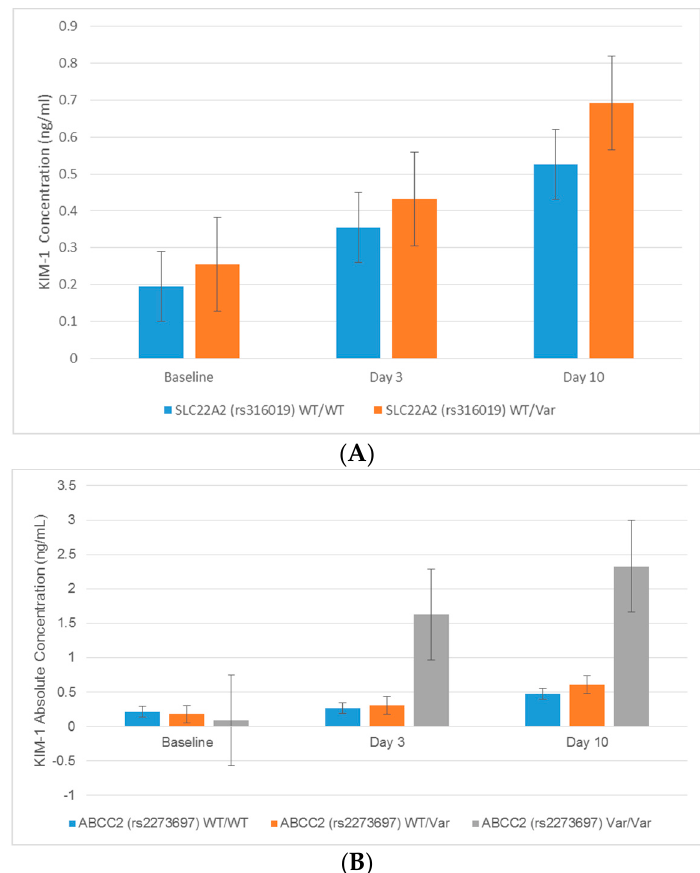
Figure 2. ( A ) Comparison of absolute KIM-1 concentrations by SLC22A2 (rs316019) genotype in ambulatory cancer patients prescribed cisplatin. Statistically significant increases of KIM-1 at baseline ( p = 0.02), Day 3 ( p = 0.03), and Day 10 ( p = 0.046) were demonstrated in patients expressing the SLC22A2 rs316019 variant. ( B ) Comparison of absolute KIM-1 concentrations to ABCC2 (rs2273697) genotype in ambulatory cancer patients prescribed cisplatin. Statistically significant increases of KIM-1 at baseline ( p = 0.02), Day 3 ( p = 0.03) and Day 10 ( p = 0.046) were demonstrated in patients expressing the ABCC2 rs2273697 variant. Error bars represent standard deviations. Abbreviations: Kidney injury molecule 1: KIM-1, Wildtype: WT, Variant: Var.